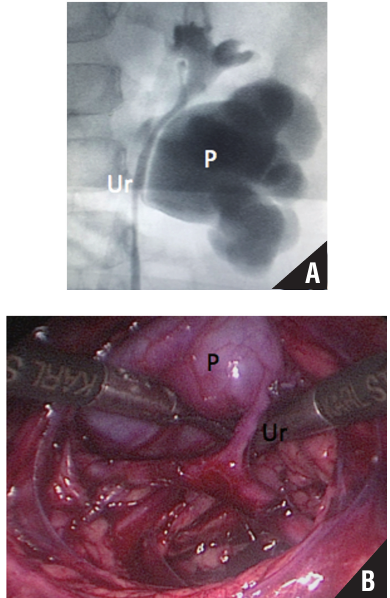
Figure 2 – Duplicated collecting system in a nine- year-old